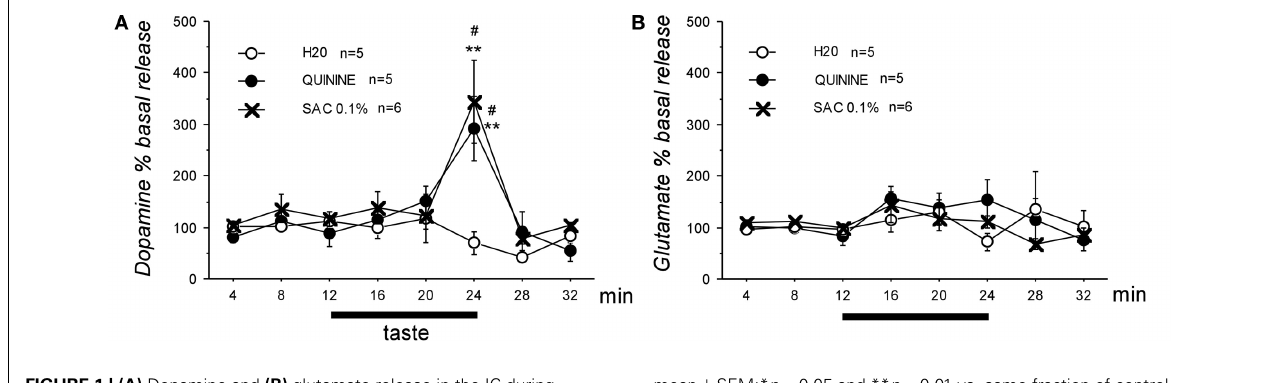
FIGURE 1 | (A) Dopamine and (B) glutamate release in the IC during the exposure to novel gustatory stimuli (saccharin 0.1%, quinine 0.005%) or water. Fractions of 4 μ L, the first three samples are baseline release before taste stimulation. Data is shown as